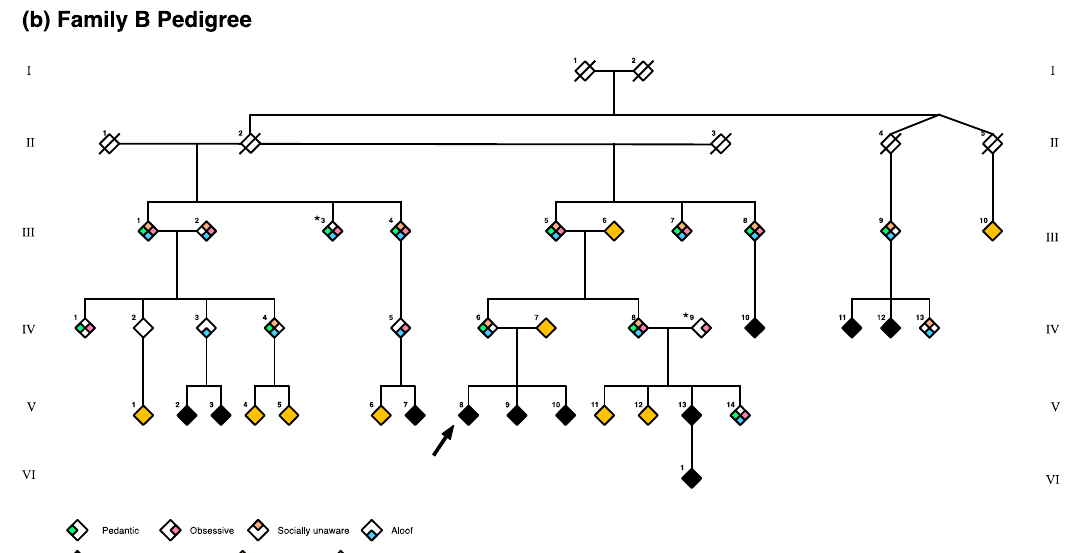
Figure 2. Scrambled pedigrees for Family A (panel a ) and Family B (panel b ) showing phenotypes and endophenotypes. All individuals with ≥ 1 endophenotype had the BAP, with the exception of two individuals from Family B (III-3 and IV-9) marked with an asterisk. These two individuals were clinically determined as unaffected but had above threshold endophenotype scores based on ROC curves. Some family members who were not phenotyped are not shown to preserve the anonymity of these families. The arrow indicates the proband shown in this pedigree. *: “All individuals with ≥ 1 endophenotype had the BAP, with the exception of two individuals from Family B (III-3 and IV-9) marked with an asterisk. These two individuals were clinically determined as unaffected but had above threshold endophenotype scores based on ROC curves.”.